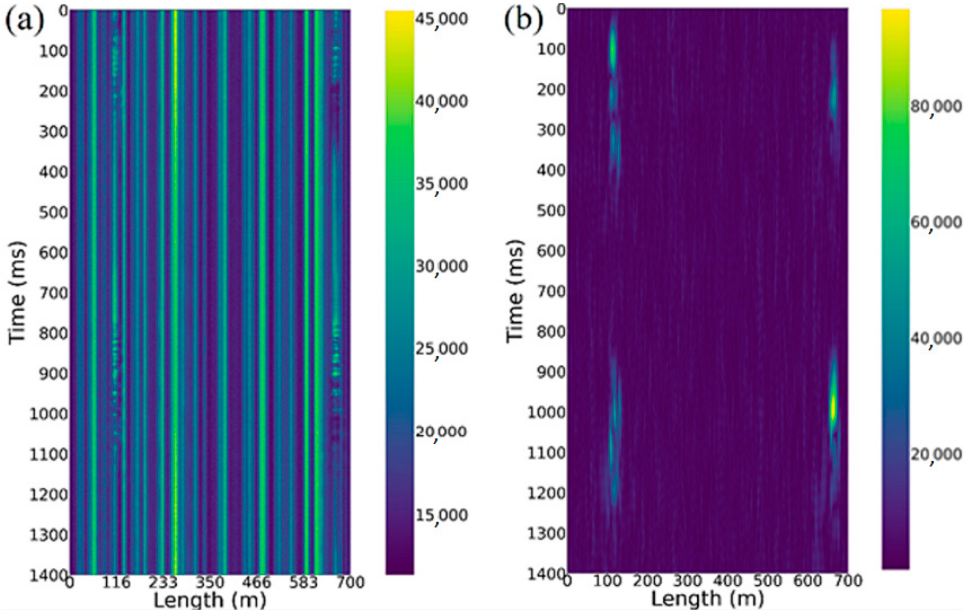
Figure 3. Visualization using a color map of ( a ) raw and ( b ) filtered charts.